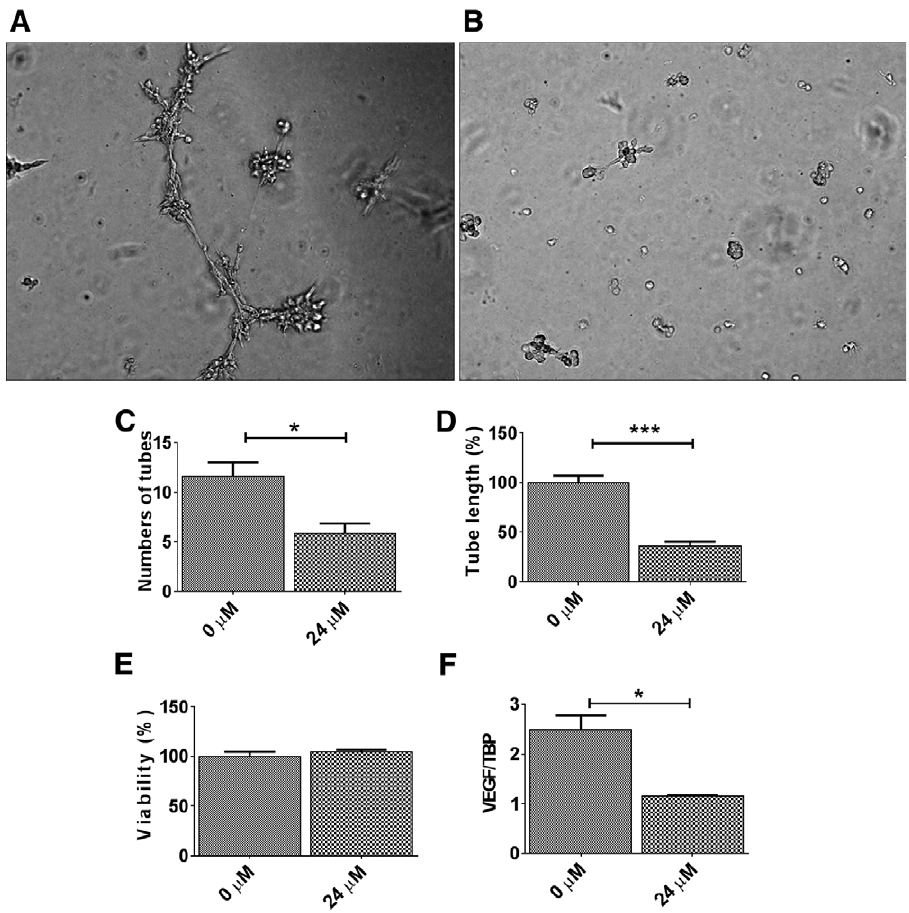
Figure 5. Maslinic acid inhibited in vitro angiogenesis. HUVEC in the untreated group formed enclosed network like structures (A), which was prevented by maslinic acid (B). Average number of tubes per field (C) and tube length (D) expressed as percentage in relation to control, are shown. Maslinic acid did not induce significant changes in viability of HUVEC (E), which confirms that the antiangio- genic activity of maslinic acid is independent of its cytotoxicity. F, Maslinic acid decreased the expression of VEGF in endothelial cells. * P < 0.05 and *** P <